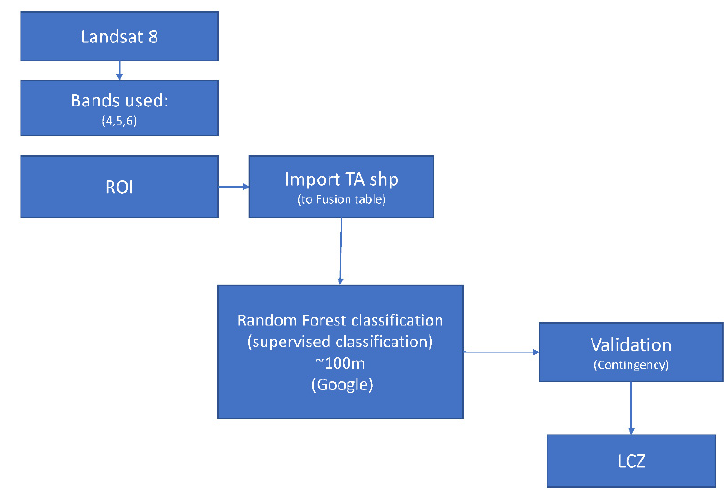
Figure 7. Workflow of the GEE method.